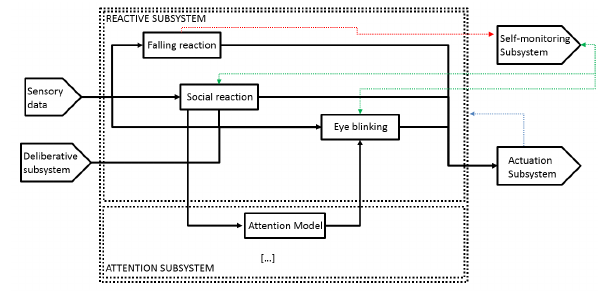
Figure 11: High level description of the reactive subsystem.